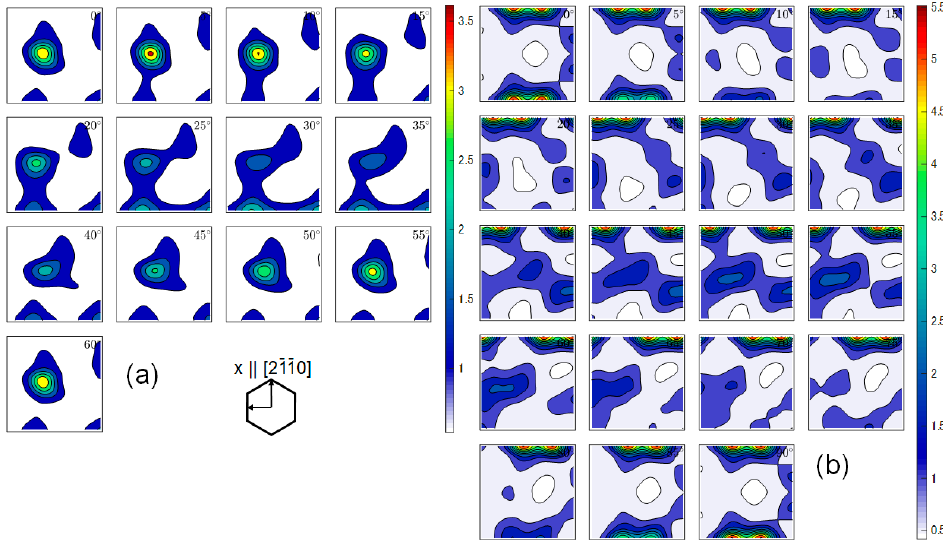
Figure 4. φ 2 sections of the orientation distribution function (ODF) of γ austenite at ( a ) E = 0 and ( b ) E = 0.42. The increment of φ 2 was 5°.